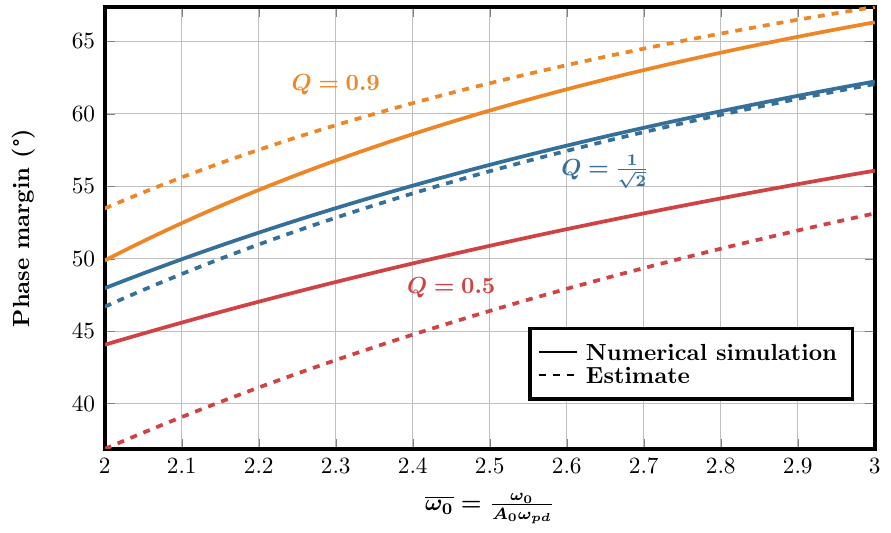
Figure 3. The phase margin estimate loses accuracy in low-power designs: as ω 0 is decreased, and depending on Q , relying on the simple estimate can either lead to overestimating or underestimating the required ω 0 for a given phase margin by up to